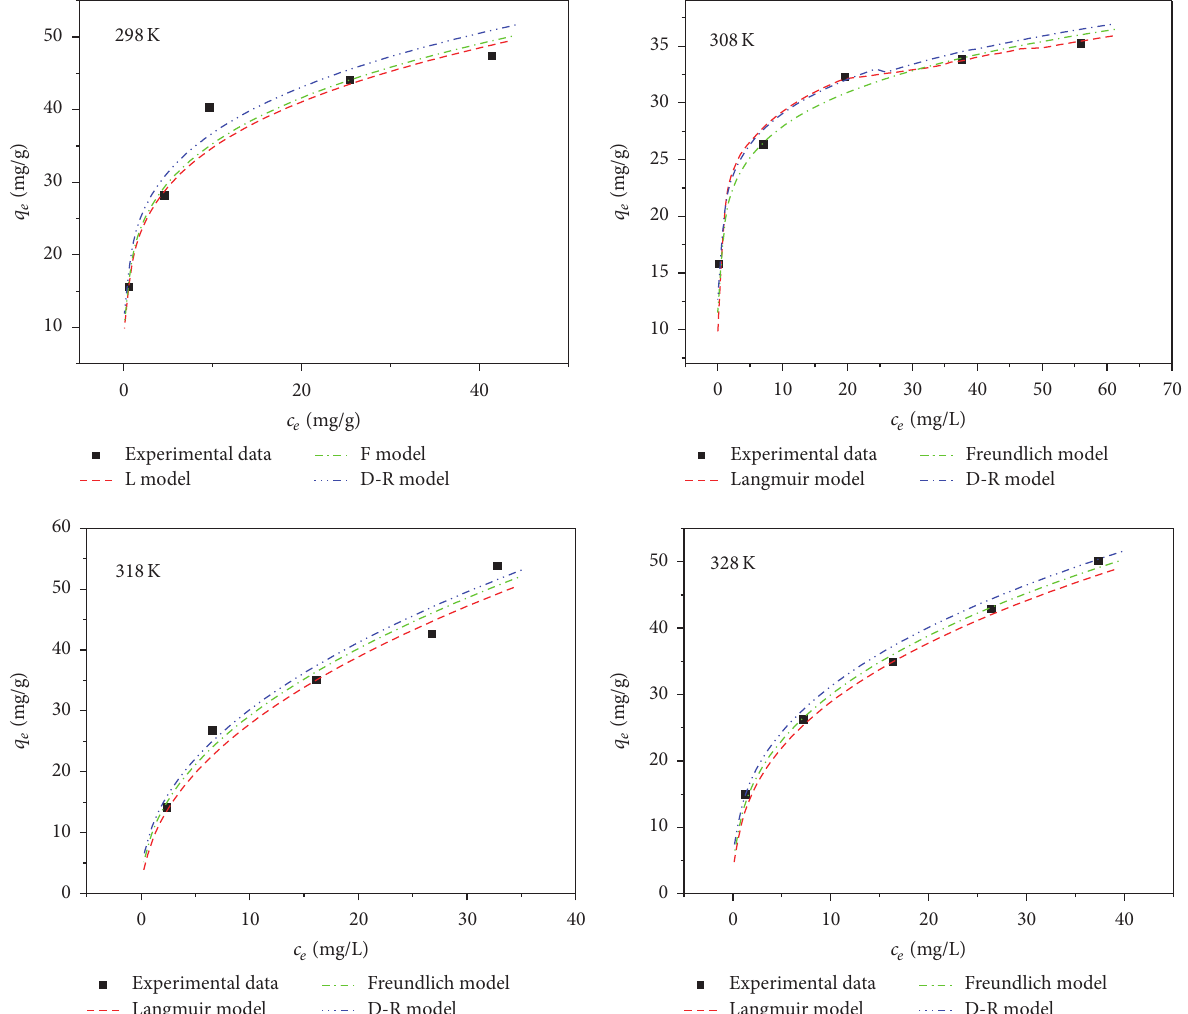
Figure 6: The adsorption isotherms at different temperature (i.e., 298, 308, 318, and 328 K). The dash lines are the fitting curves of Langmuir, Freundlich, and D-R